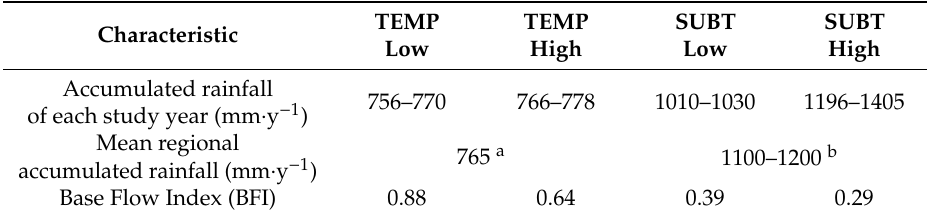
Table 2. Main climatic and hydrological characteristics of the four benchmark catchments monitored at high frequency (nstreams = 4, 2-year period), showing annual accumulated rainfall in mm for each study year (sources: a [56], b [55]). Abbreviations: TEMP: temperate streams; SUBT: subtropical streams; Low and High: low and high-farming